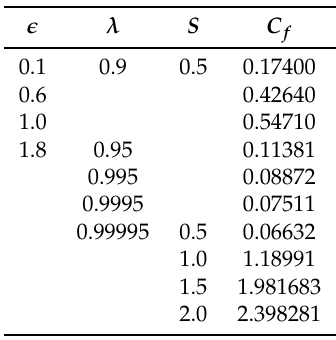
Table 2. Variation in skin friction with different values of the parameters (cid:101) , λ , and S . (cid:101) λ